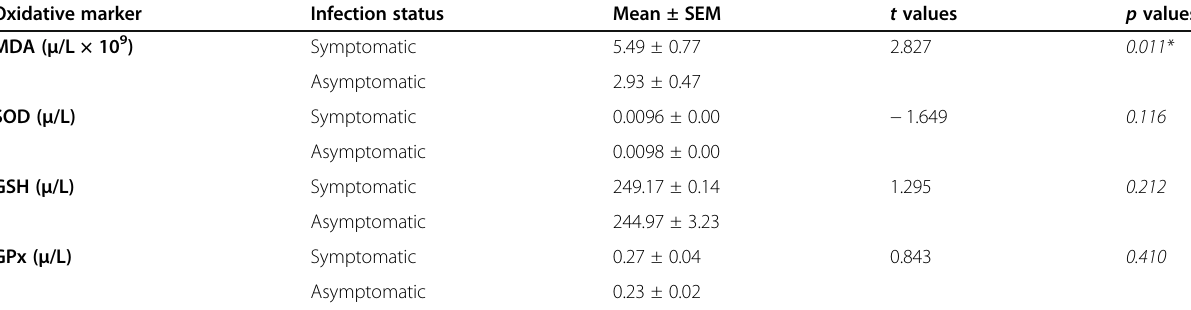
Table 4 Relationship between oxidative stress markers and malaria symptoms in infected patients Oxidative marker Infection status